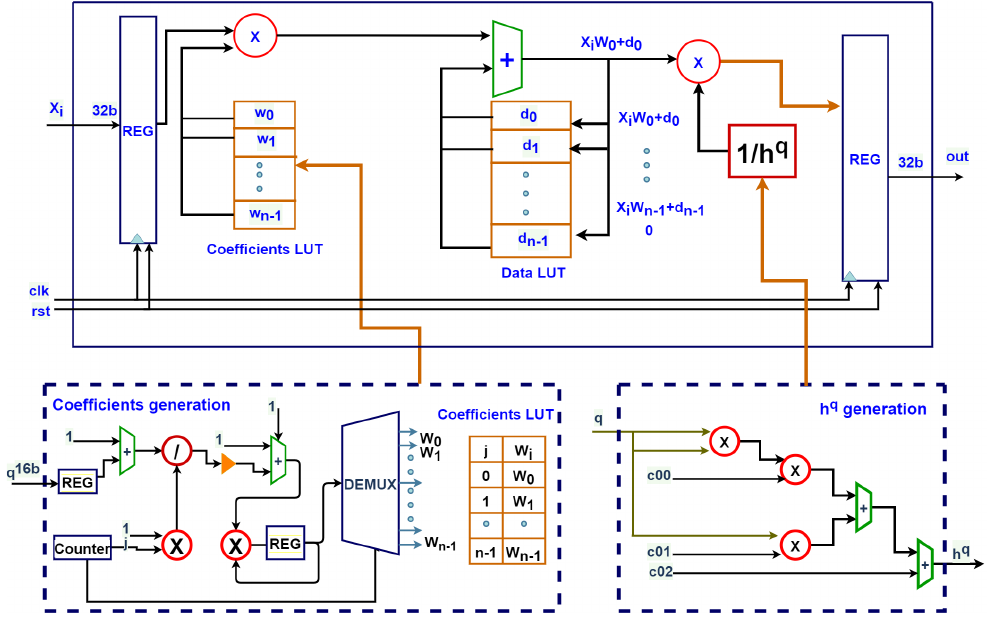
Figure 2. The hardware architecture of the proposed approach for the integrator and differentiator GL